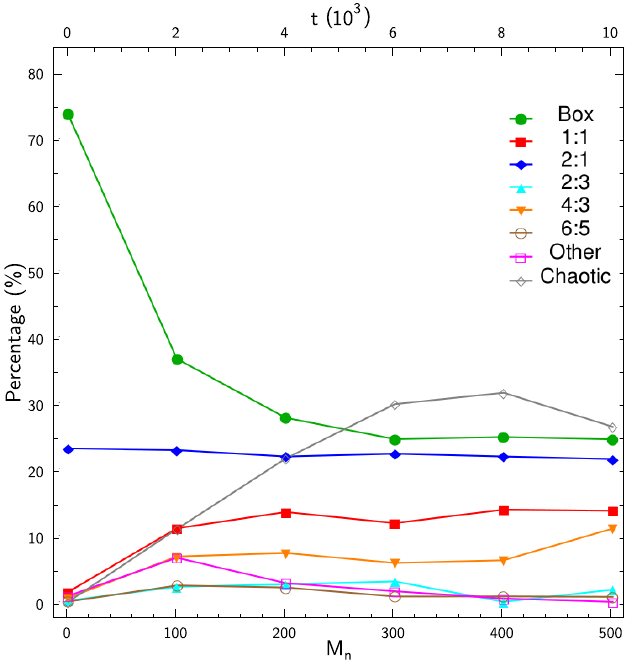
Fig. 5. Time-evolution of the percentages of the different types of orbits in the phase ( R; ˙ R ) space of our galaxy model, as a function of the final mass of the nucleus M n . the 2:3, 6:5 and “other”) possess throughout very low percentages (always less